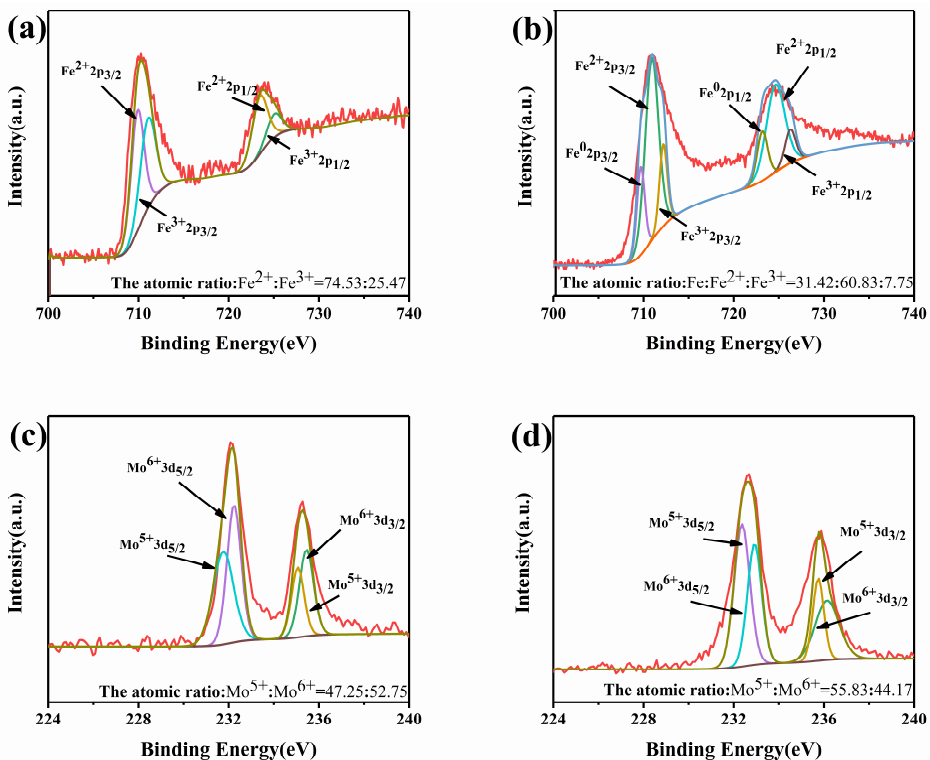
Figure 3. The chemical state of the elements. Fe 2p ( a ) and Mo 3d ( c ) XPS of oxidized 0.075Fe(S)-SFMO; Fe 2p ( b ) and Mo 3d ( d ) XPS of reduced 0.075Fe(S)-SFMO.